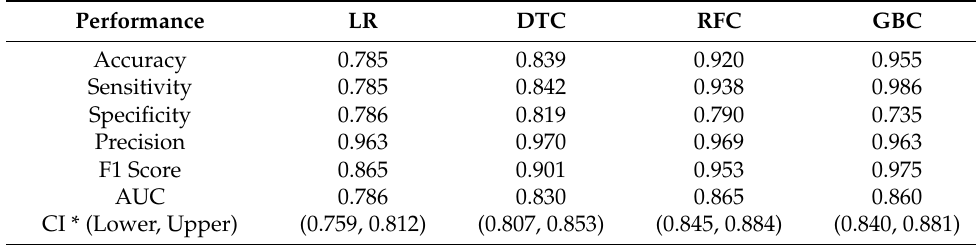
Table 2. Comparison of the performance of the machine learning classification models using holdout